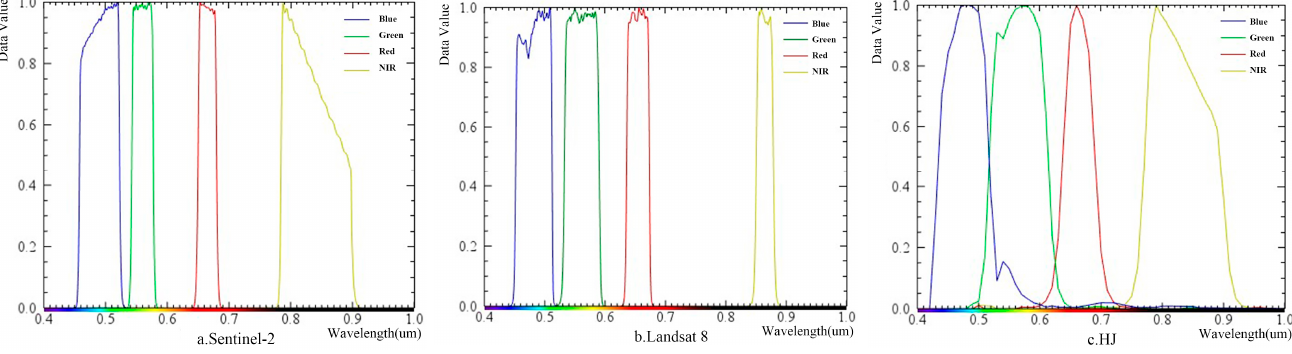
Figure 2. The spectral response function of the sensor (( a – c ) are the spectral responses of Sentinel-2, Landsat 8, and HJ respectively).